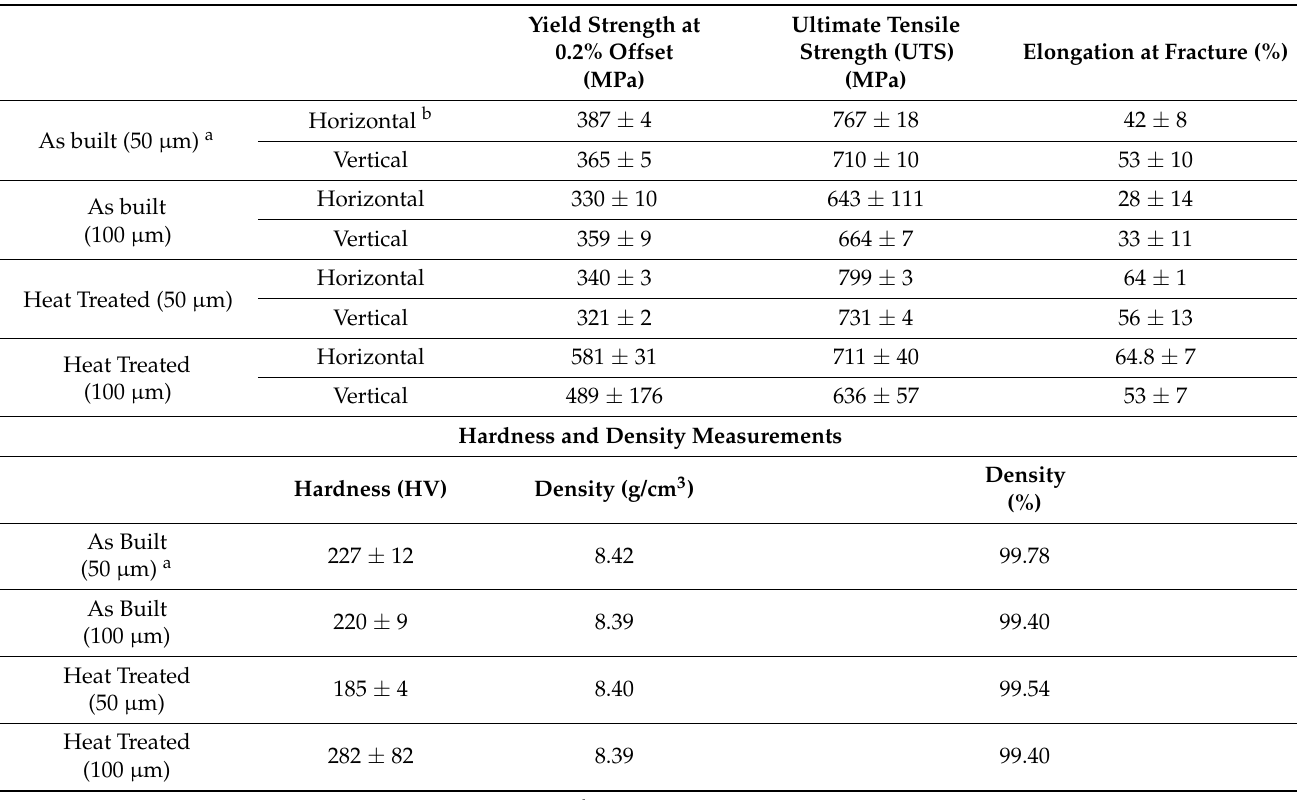
Table 3. Average mechanical properties of as-built parts and their corresponding ( ± ) standard deviation; hardness (HV) and density